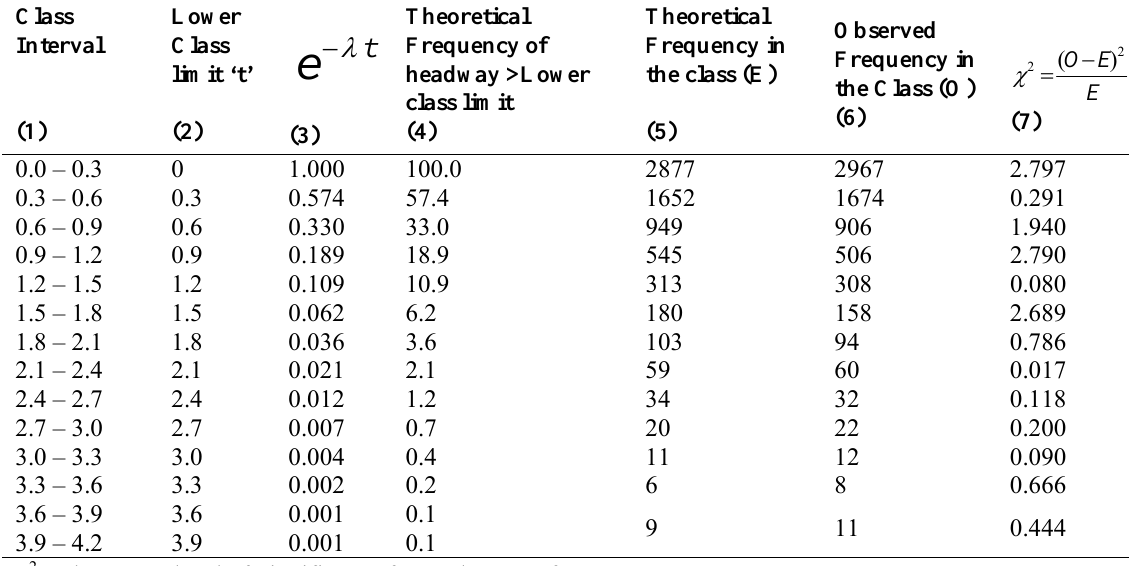
χ 2 Value at 5% level of Significance for 11 degrees of freedom is =